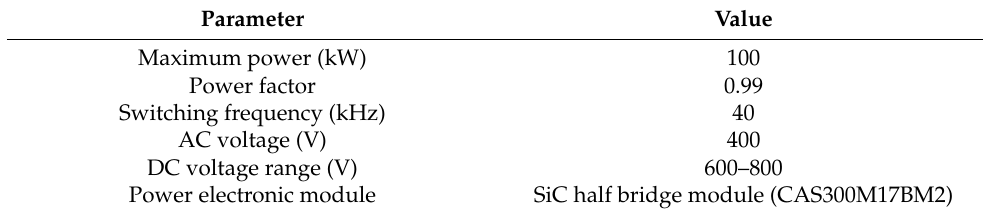
Table 1. Specifications of the considered off-board charger.